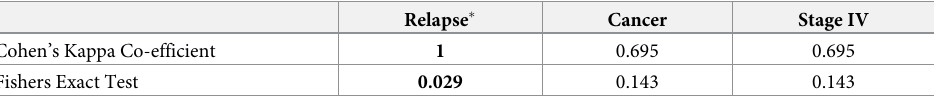
Table 3. Comparison of LVs with high inflammation vs those with low inflammation only (n = 7) using Cohen’s Kappa Coefficient and Fisher’s exact test, as described in Table